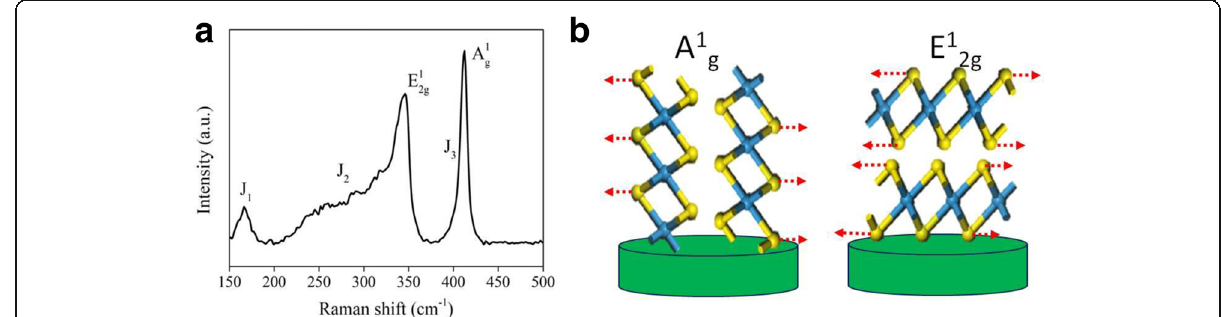
Fig. 5 a Raman spectrum of vertical 1T-WS 2 nanosheets. b Schematics of preferentially excited A 1 g Raman mode for edge-terminated nanosheets (top) and E